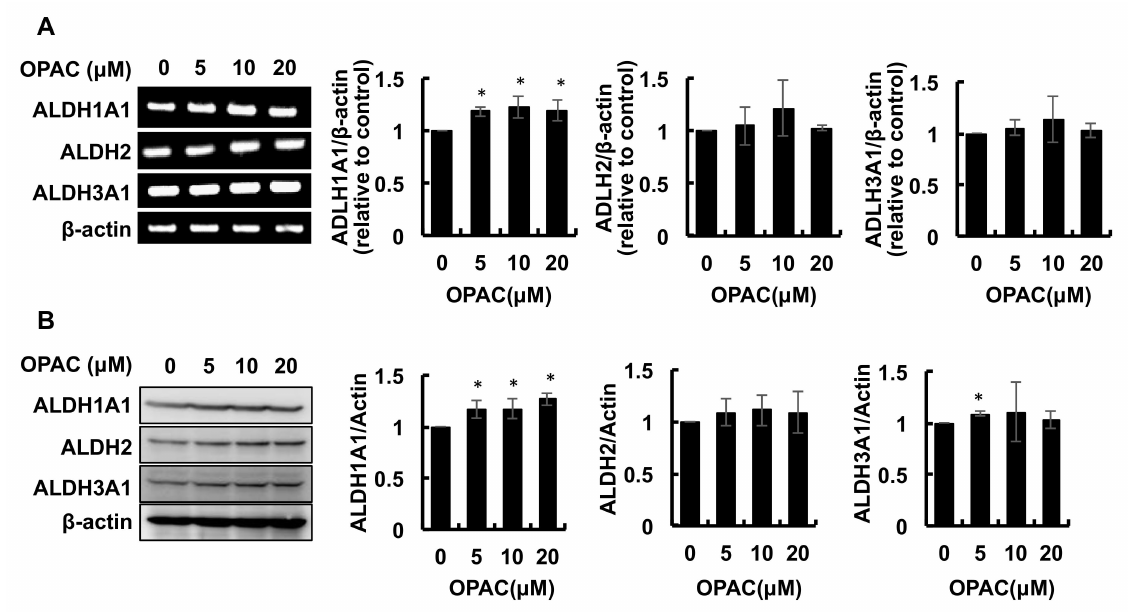
Figure 2. Modulating effects of OPAC on the gene and protein expressions of the classical family of ALDHs: ALDH1A1, ALDH2, and ALDH3A1. ( A ) The total RNA was extracted from the Hepa1c1c7 cells treated with OPAC for 6 h; then, an RT-PCR analysis for each gene was carried out. Representa- tive blots and quantitative data for ADLH1A1, ADLH2, and ADLH3A1 are shown. ( B ) Hepa1c1c7 cells were treated with OPAC for 6 h, and the total cell lysates were subjected to a Western blot analysis. All values are expressed as means ± SD of three separate experiments. * p < 0.05 vs.